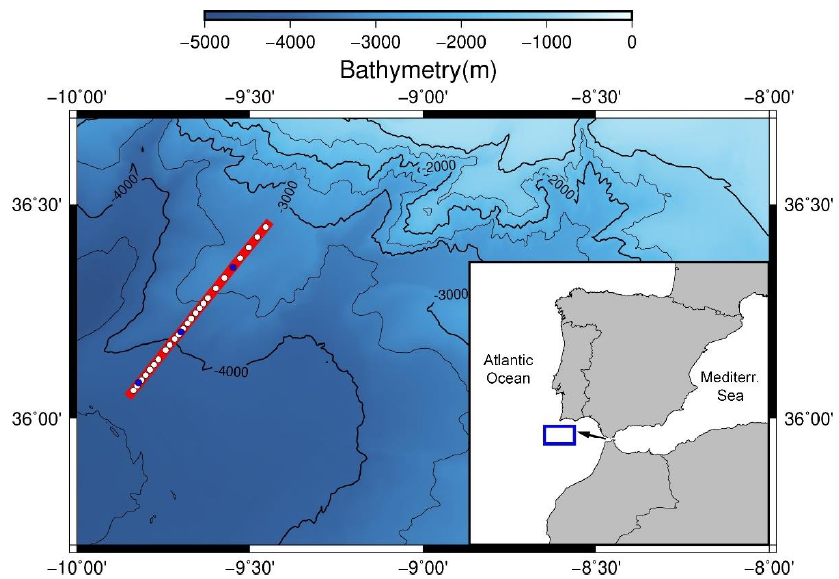
Figure 1. Bathymetry of data collection region. Red line = seismic transect GOLR12; white dots = 24 XBT casts deployed coincident with seismic acquisition; blue dots = 3 CTD casts deployed before and after the seismic survey; Inset shows location of the research area, and schematic of Mediterranean outflow pathway. Bathymetry was produced from the GEBCO 2020 dataset.